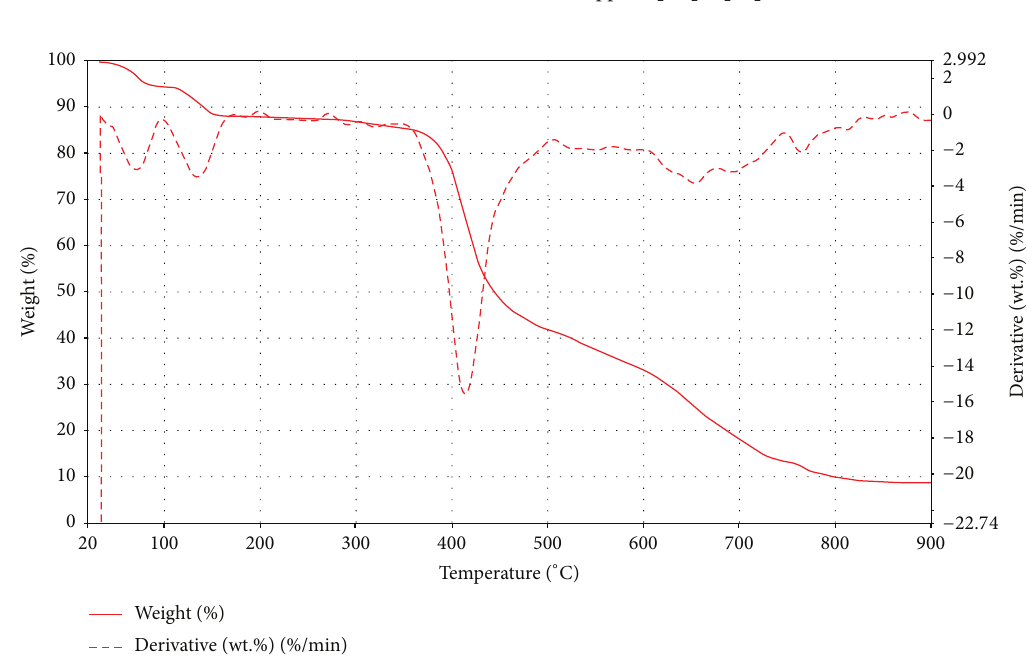
Figure 9: TGA and DTG curve of Co(Bmpp-Sn) 2 (H 2 O) 2 ⋅ H 2 O ( 2b ).